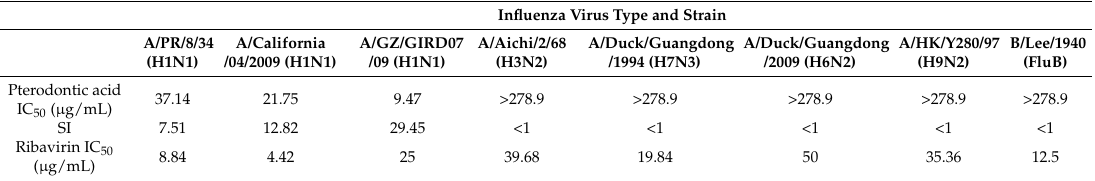
Table 1. Antiviral activity of pterodontic acid against influenza viruses Influenza Virus Type and Strain